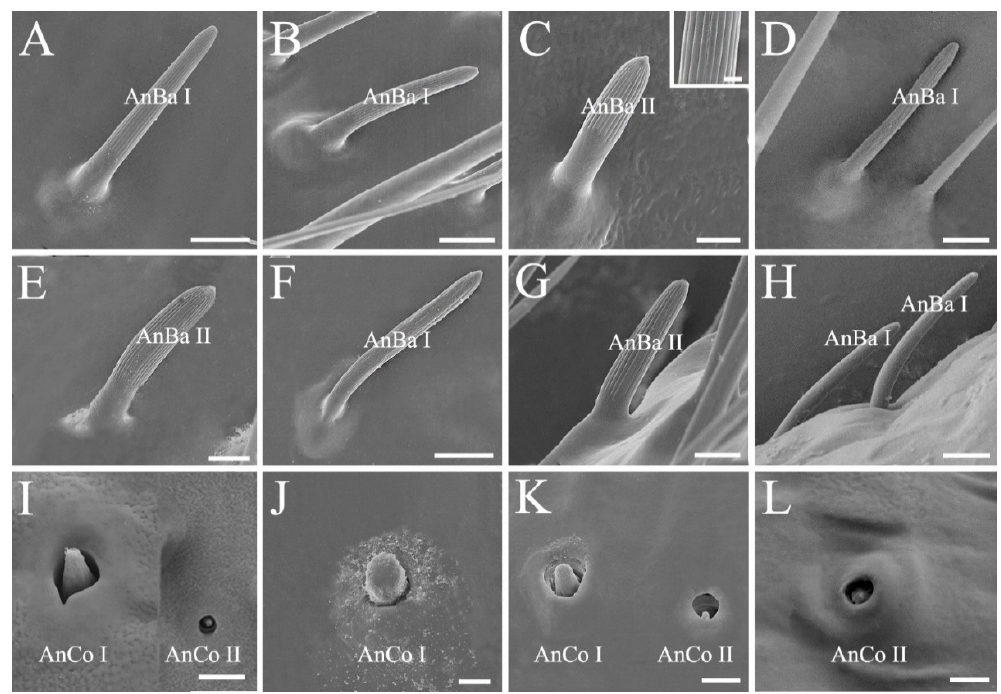
Figure 4. Antennal sensilla basiconica and sensilla coeloconica of the six pentatomid species. ( A ) Cressona divaricata ; ( B , I ) Eocanthecona furcellata ; ( C ) Eurydema dominulus , with grooves shown in the ox; ( D , E , J ) Halyomorpha halys ; ( F , G , K ) Plautia crossota ; and ( H , L ) Scotinophara lurida . Scale bars: ( A , B , D , F , H ) 5 µ m, ( C , E , G , I – L ) 2.5 µ m, and ( C ) 0.5 µ m. Abbreviations: AnBa I–II, antennal sensilla basiconica I–II; AnCo I–II, antennal sensilla coeloconica I–II. Table 1. Morphological similarity and disparity of antennae and labia between phytophagous and predatory stink bugs. Morphological